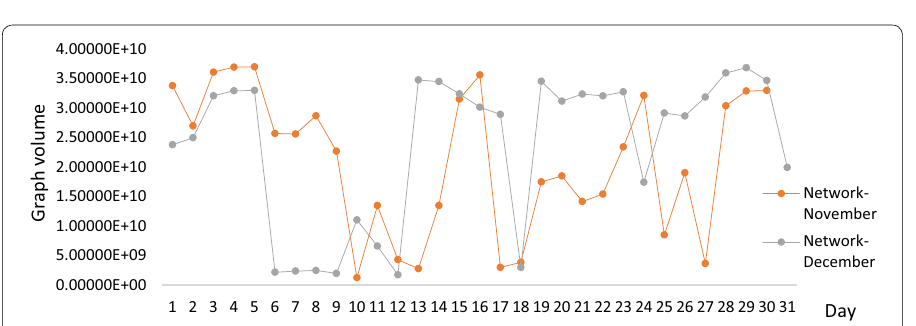
Fig. 10 Evolution of network volume at daily temporal resolution for November and December